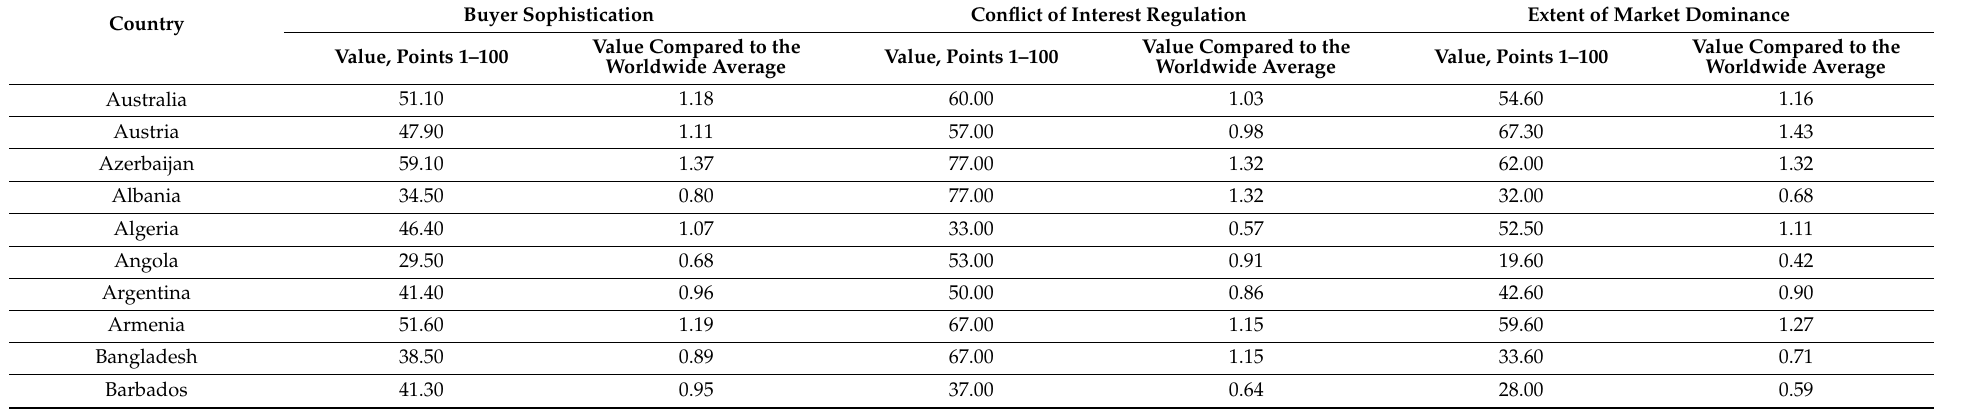
Table A2. Marketing statistics in